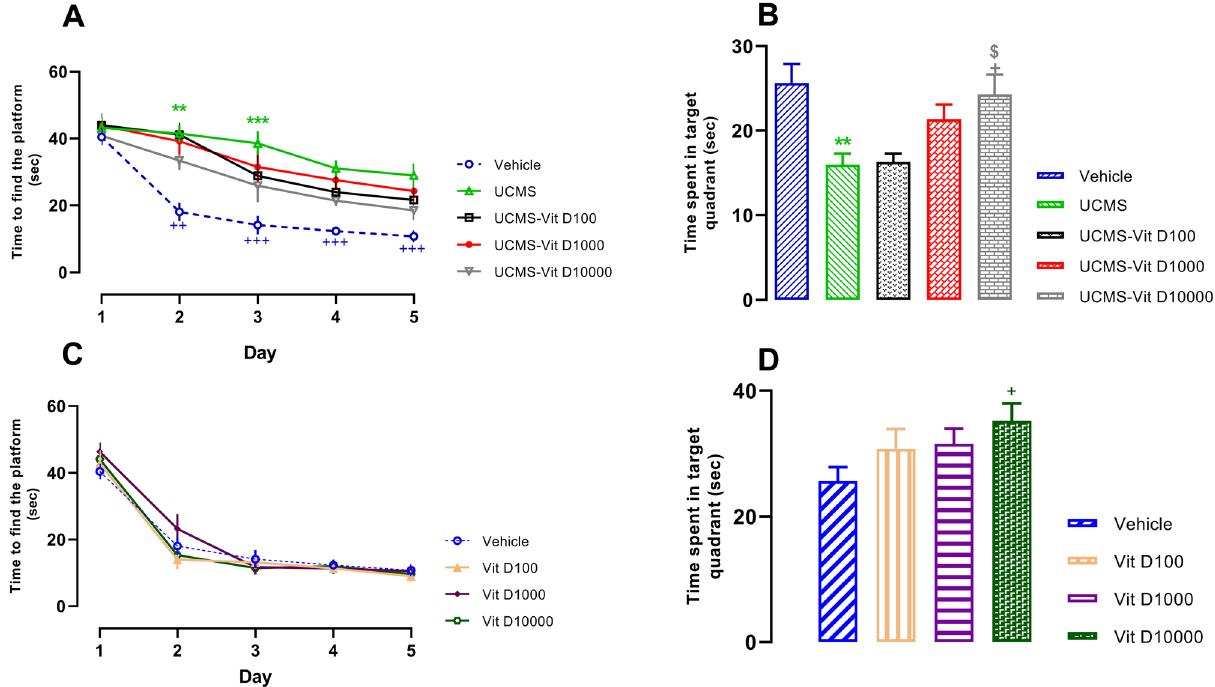
Figure 2. Comparison of MWM test results in different groups. ( A ) time to find the platform in UCMS groups. ( B ) time spent in target quadrant in UCMS groups. ( C ) time to find the platform in Vit D groups and ( D ) time spent in target quadrant in Vit D groups. Data are presented as mean ± SEM, n = 10. For A and B sections: + + P < 0.01 and + + + P < 0.001 versus day 1 in Vehicle group ** P < 0.01 and *** P < 0.001 versus Vehicle group, + P < 0.05 versus UCMS group and $ P < 0.05 versus UCMS-Vit D100 group. For D section: + P < 0.05 versus vehicle group.